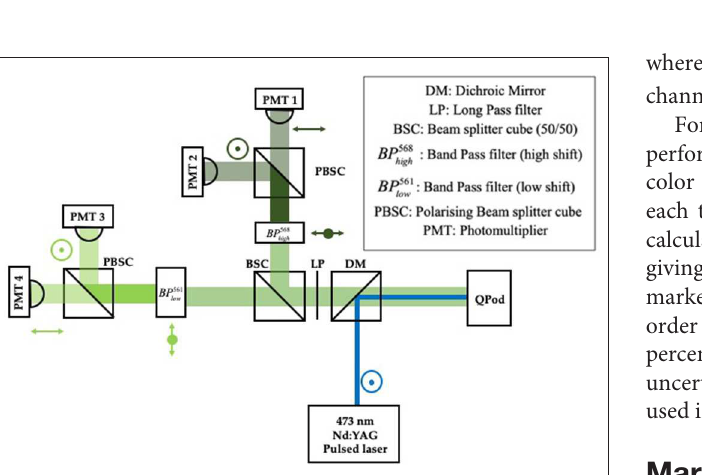
FIGURE 2 | Experimental design of the 4-channel Raman